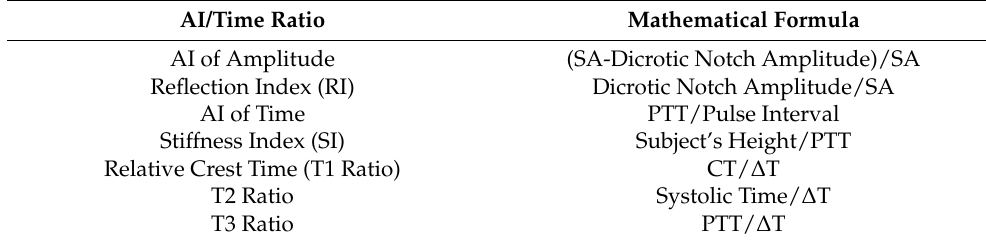
Table 1. Augmentation Indices and Time